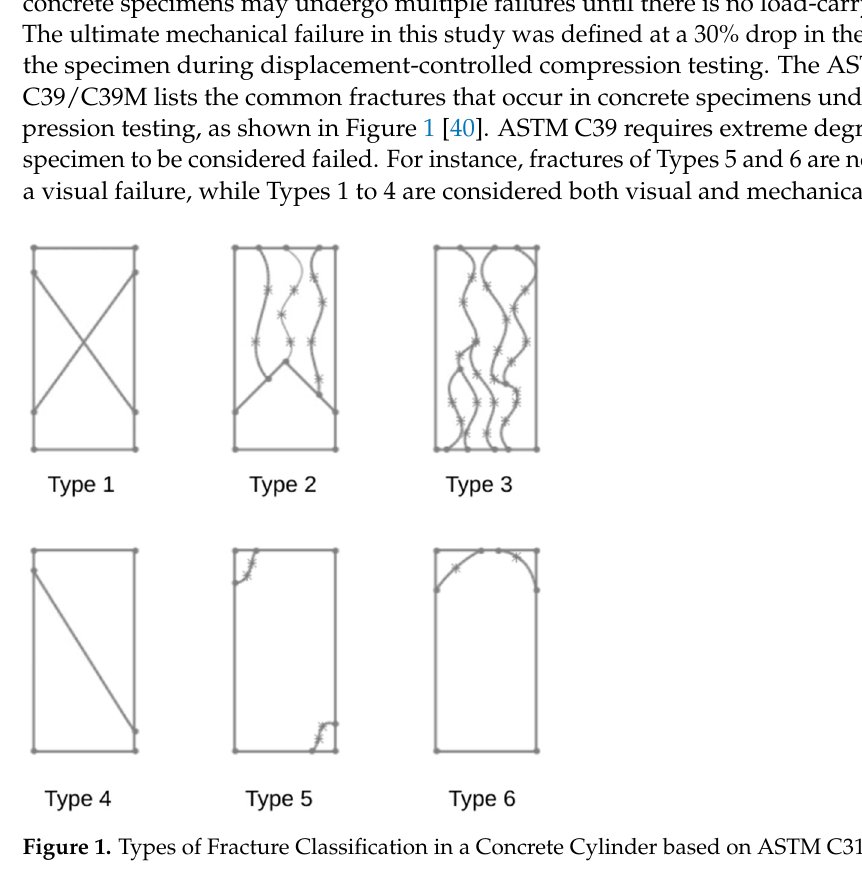
Figure 1. Types of Fracture Classification in a Concrete Cylinder based on ASTM